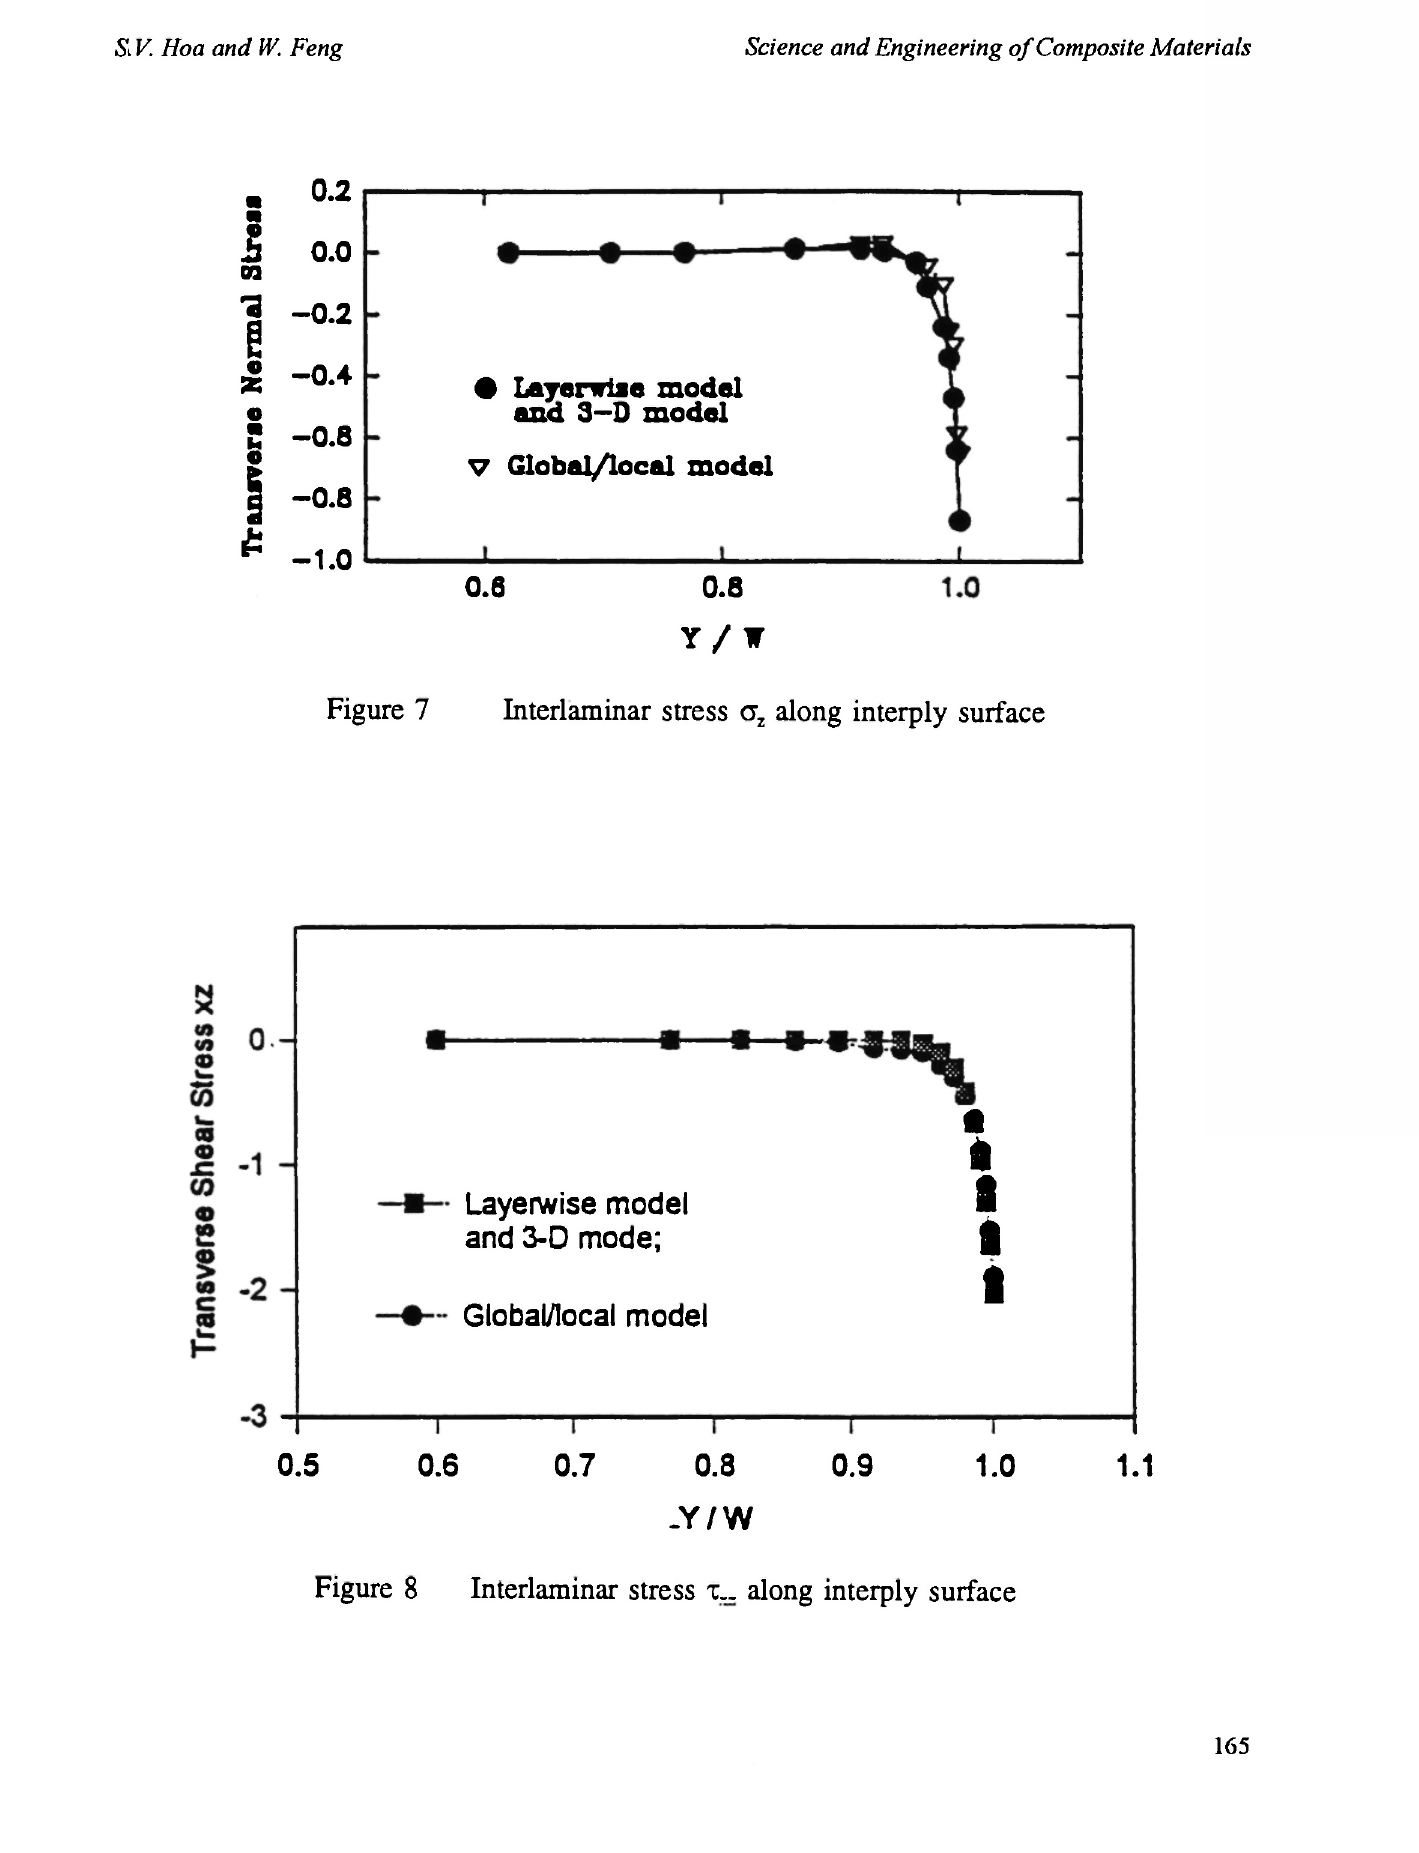
Figure 8 Interlaminar stress along interply